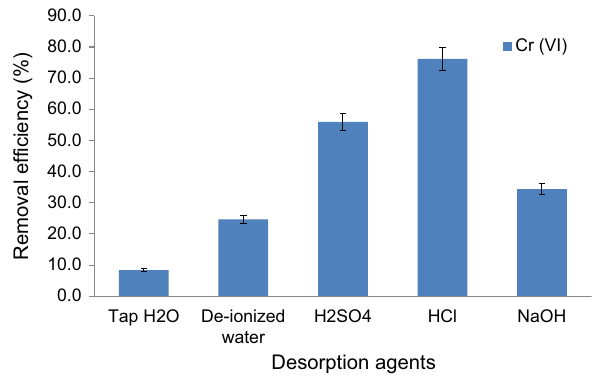
Fig. 1 Desorption of Cr(VI) ions adsorbed on groundnut husk